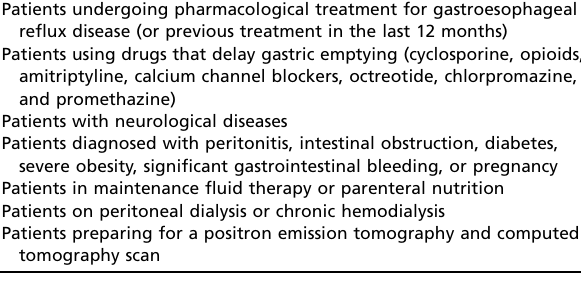
Table 1 - Exclusion criteria for clear liquid prescription after hospital